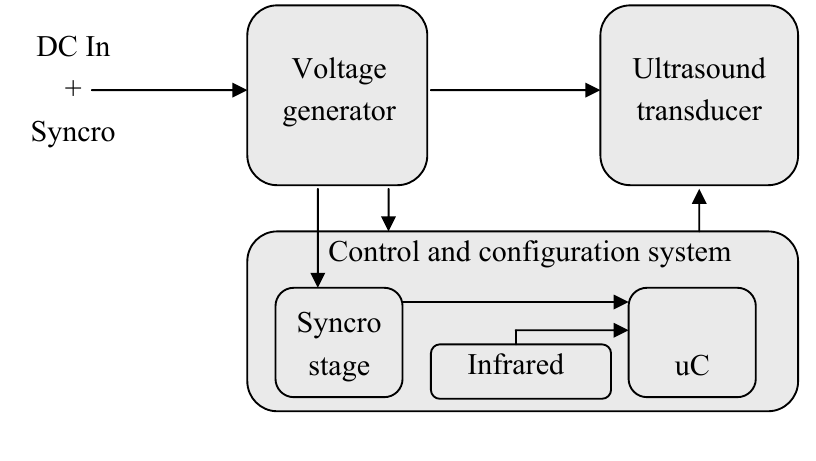
Figure 7 . Emitter bloc